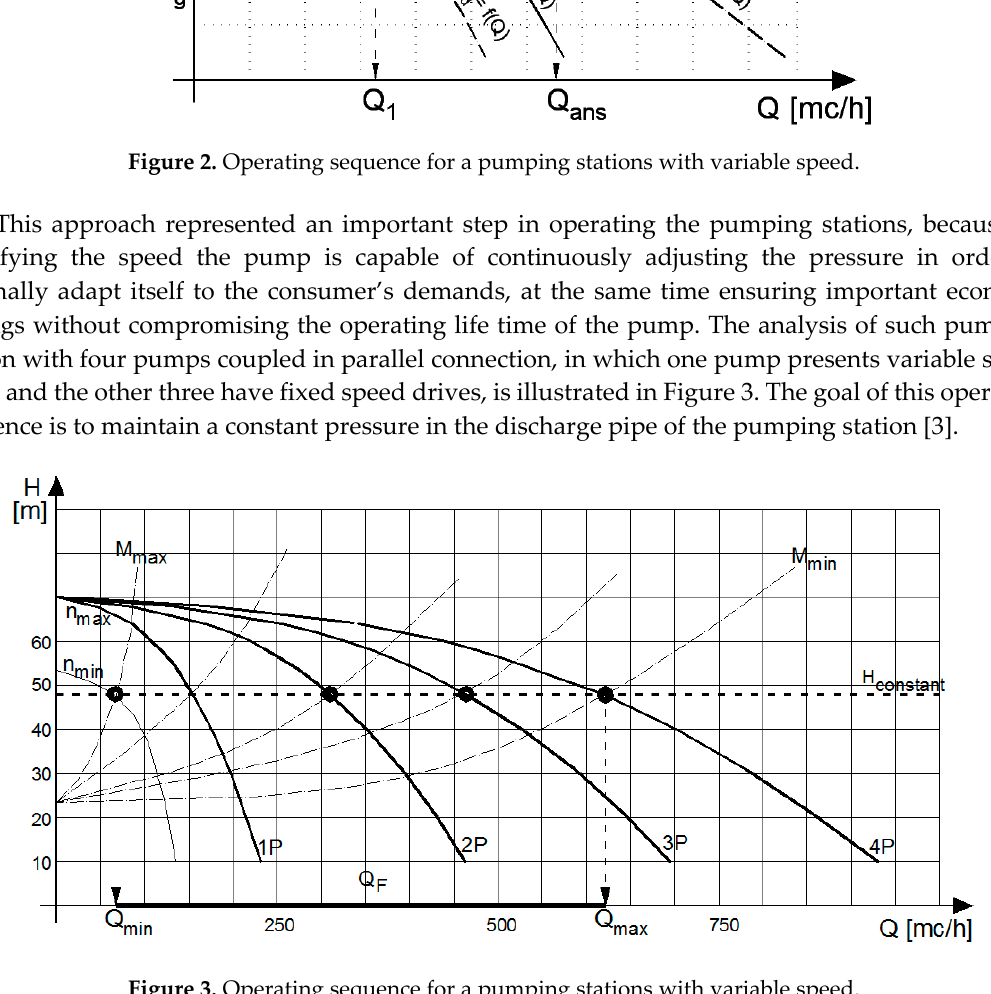
Figure 3. Operating sequence for a pumping stations with variable